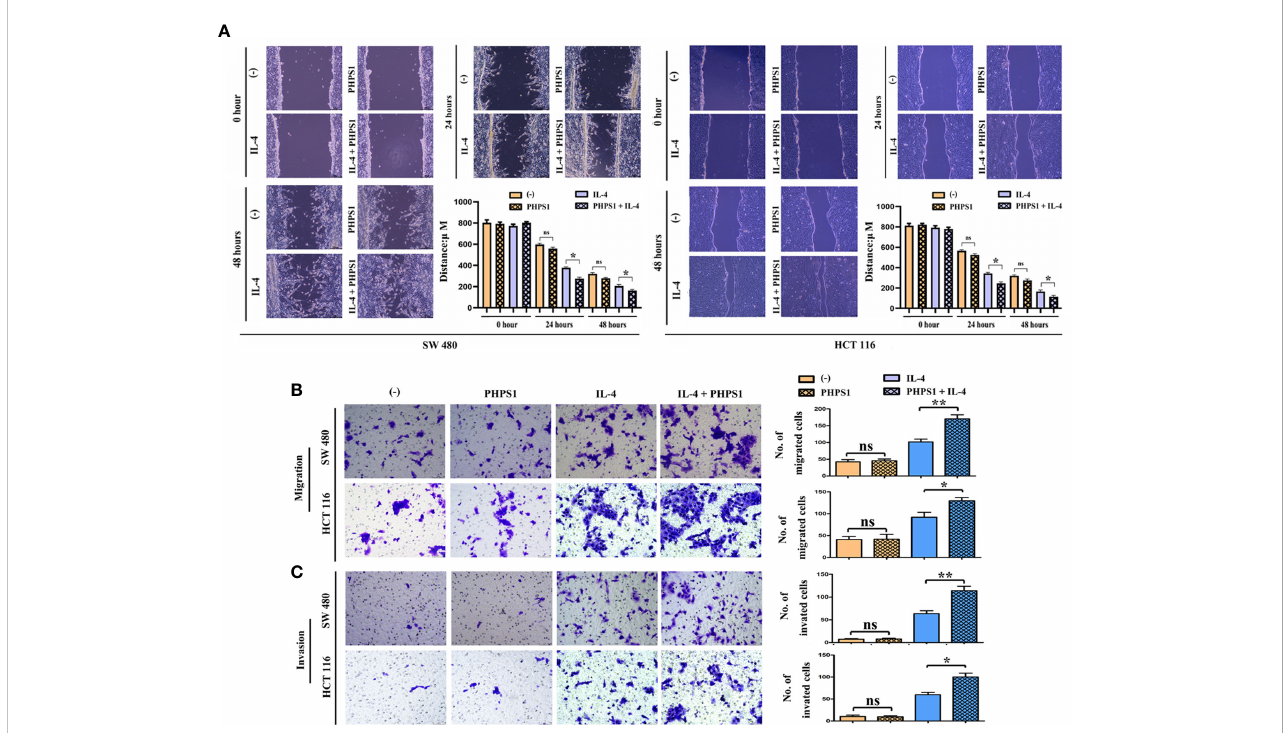
FIGURE 6 Low SHP-2 expression facilitated the migration and invasion abilities of CRC cells co-cultured with M2 macrophages. (A) Wound healing assay was used to evaluate the migration abilities of CRC cells; (B) Transwell assay was used to evaluate the migration abilities and (C) invasion abilities of CRC cells; ns indicated no statistical difference; *P <0.05 or **P <0.01 indicated vs. IL-4 group. All experiments were independently repeated three times. SHP-2, Src homology region 2 domain-containing protein tyrosine phosphatase-2; CRC, colorectal